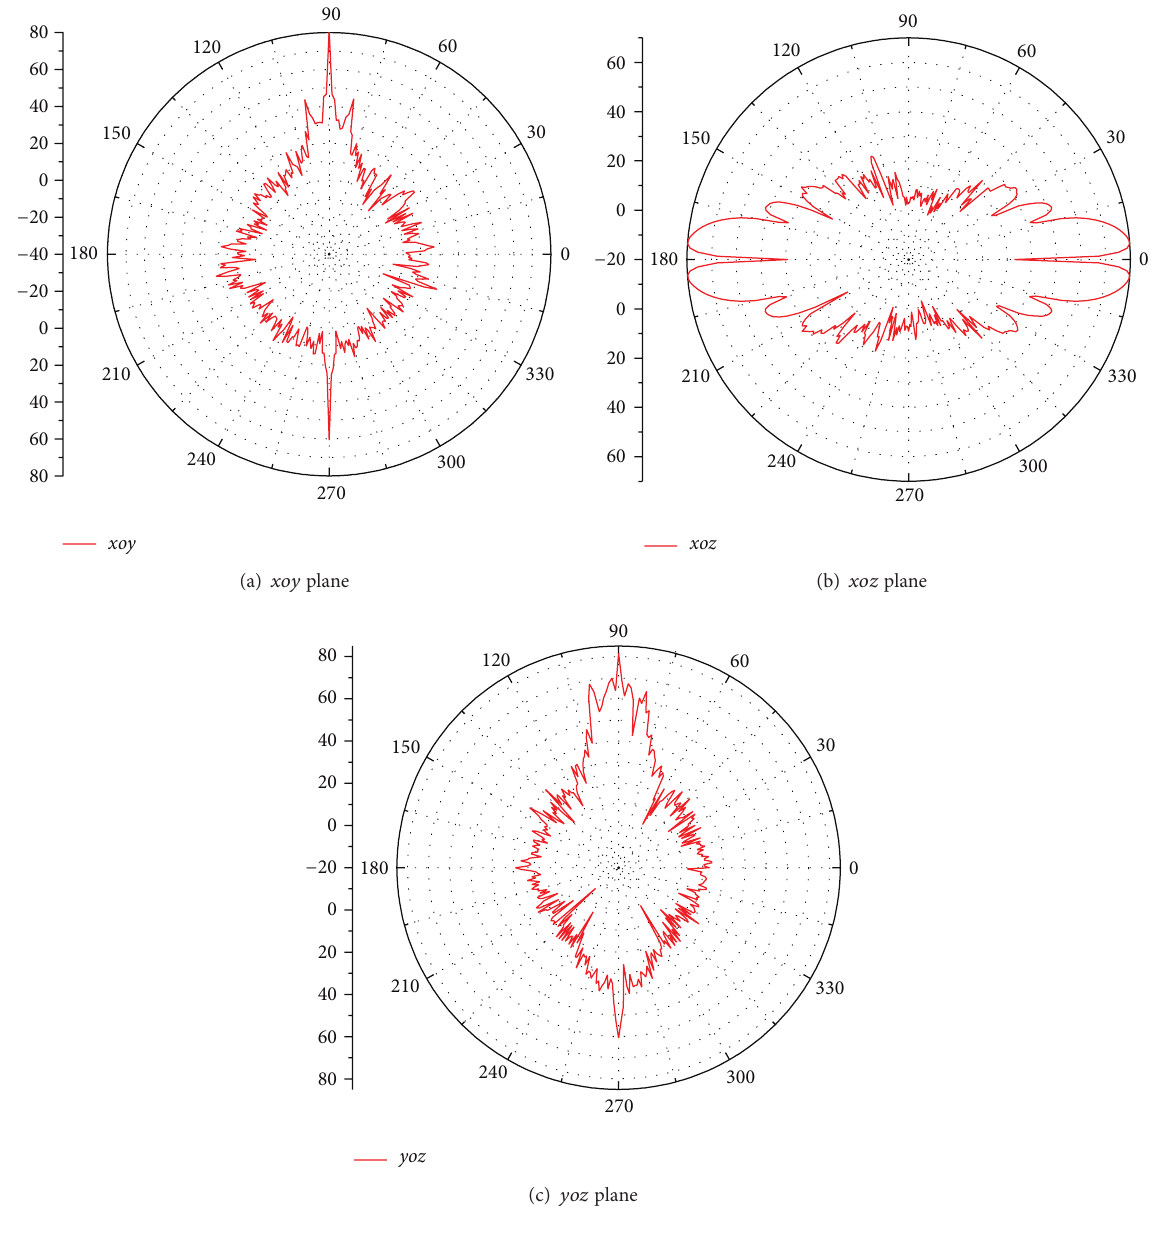
Figure 12: The RCS of the